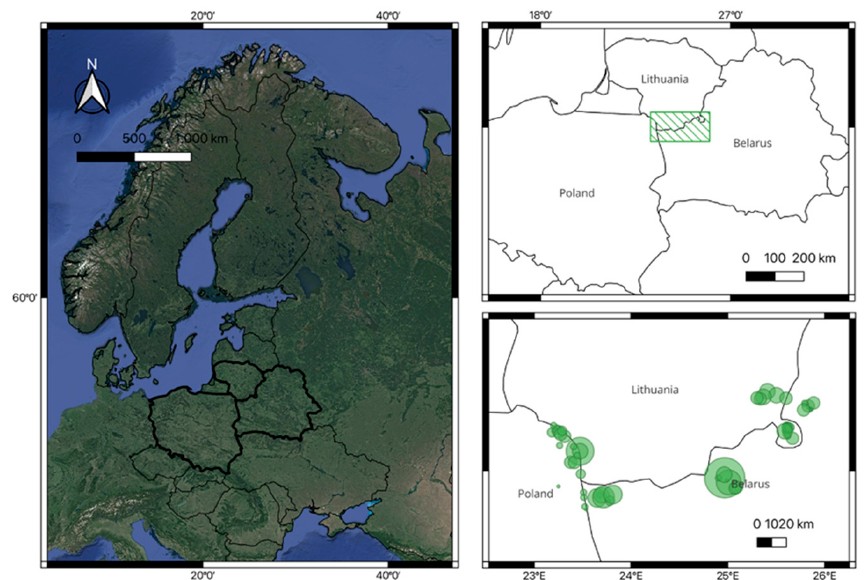
Figure 1. Map of the study area. The border region, which consists entirely of lowlands with a maximum altitude of ca. 240 m above sea level, extends over parts of northern Podlasie (NE Poland), Dz ū kija (SE Lithuania), and various districts in the Neman River Basin (NE Belarus); designed with QGIS 3.22.16 ‘Bia ł owie ż a’.